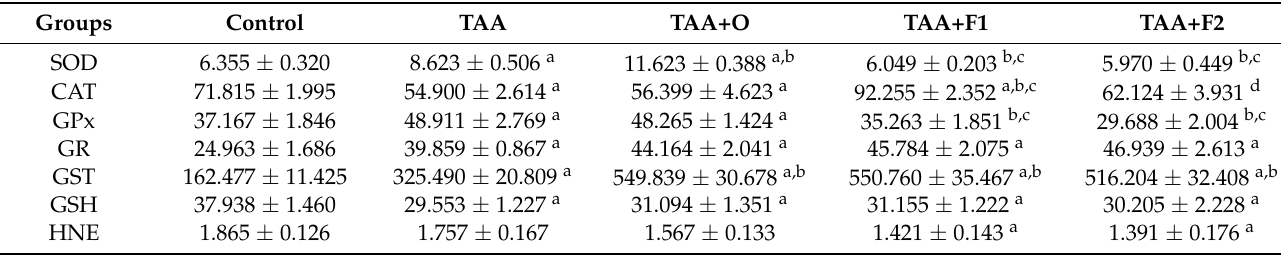
Table 4. Liver activities of total superoxide dismutase (SOD, U/mg tissue), catalase (CAT, U/mg tissue), glutathione peroxidase (GPx, U/g tissue), glutathione reductase (GR, U/g tissue) and glutathione S-transferase (GST, U/g tissue), as well as glutathione (GSH, µ mol/g tissue), and 4-hydroxynonenal content (4-HNE, µ mol/L) in control, and rats treated with thioacetamide (TAA), thioacetamide + virgin olive oil (TAA+O), thioacetamide + C60 fullerene lower dose (TAA+F1), and thioacetamide + C60 fullerene higher dose (TAA+F2). The data are given as mean ± standard error. Data are given as mean ± standard error. Minimal significance level: p <